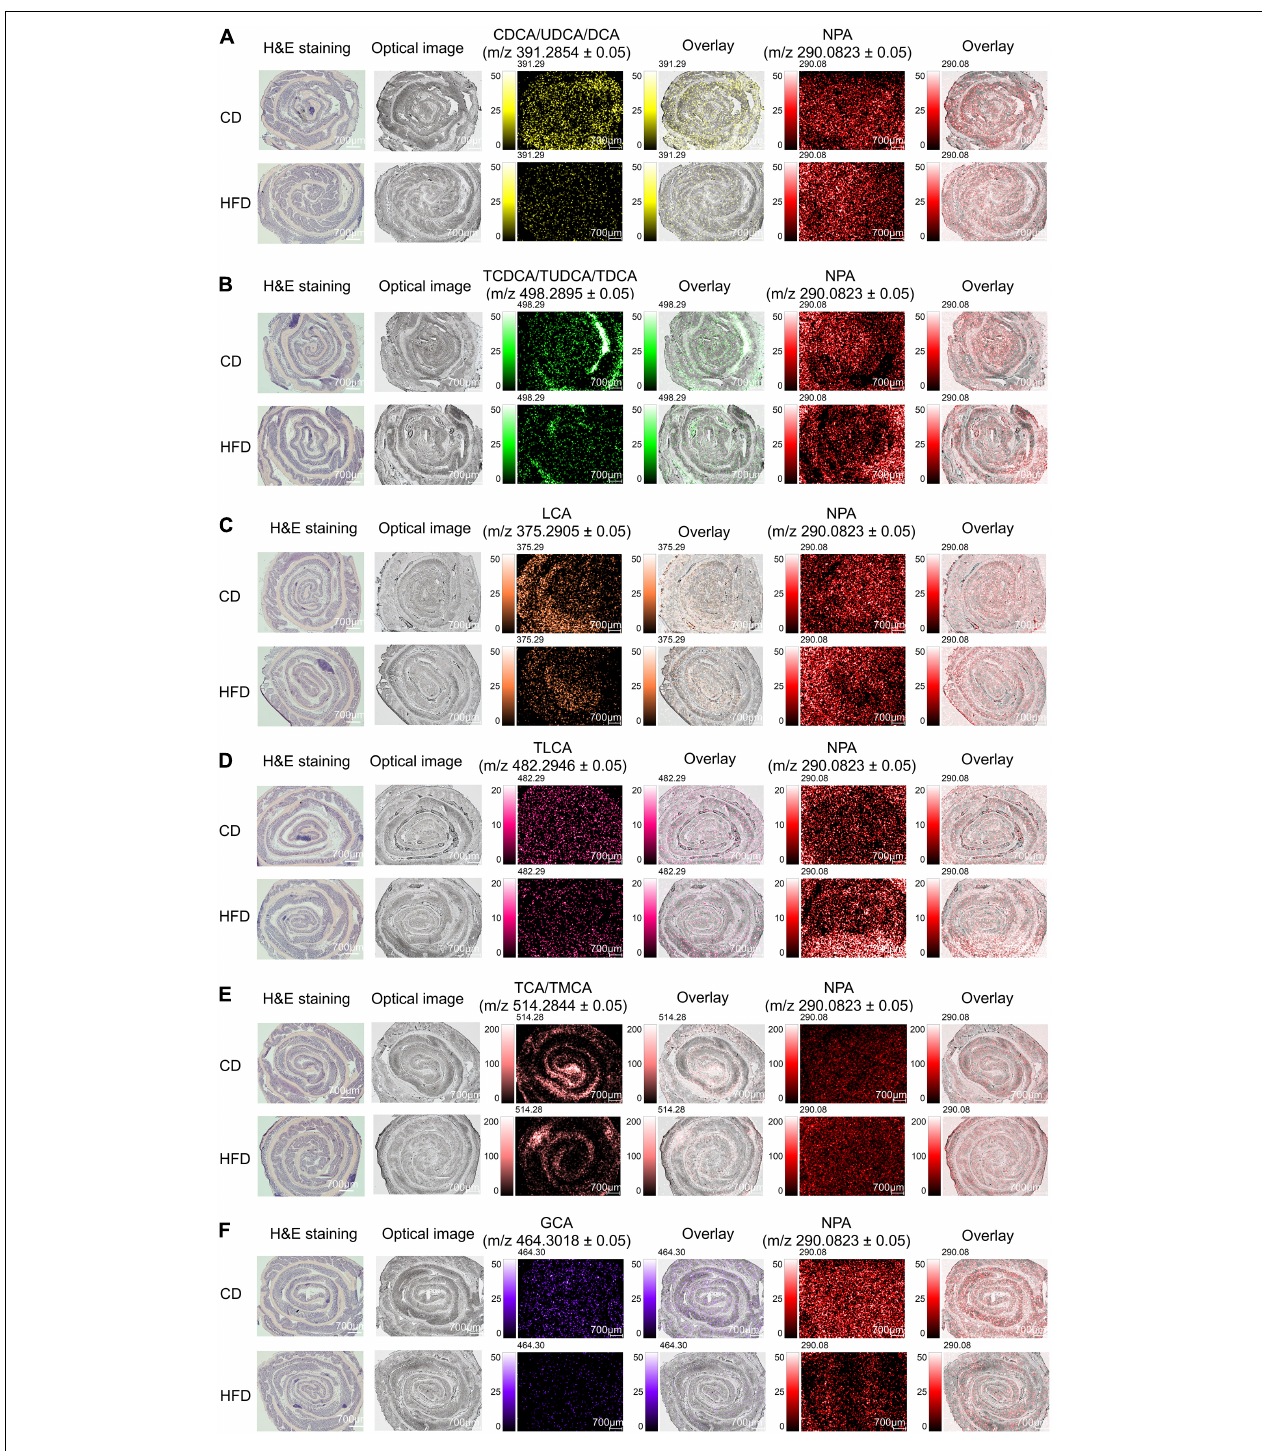
FIGURE 4 | MS imaging-based visual mapping profiles of BAs distributed within regions of colon. MS ion images representing spatial distributions of NPA ( m/z 290.0823 ± 0.05) and the identified BAs at CDCA/UDCA/DCA m/z 391.2854 ± 0.05 (A) , TCDCA/TUDCA/TDCA m/z 498.2895 ± 0.05 (B) , LCA m/z 375.2905 ± 0.05 (C) , TLCA m/z 482.2946 ± 0.05 (D) , TCA/TMCA m/z 514.2844 ± 0.05 (E) and GCA m/z 464.3018 ± 0.05 (F) for the whole section of mouse colon (Scale bars: 700 µ m). Overlay: Overlay of each MS ion image and optical image. All ion images were normalized to the 9AA matrix signal. Abbreviation: CD,control diet group; HFD, high-fat diet